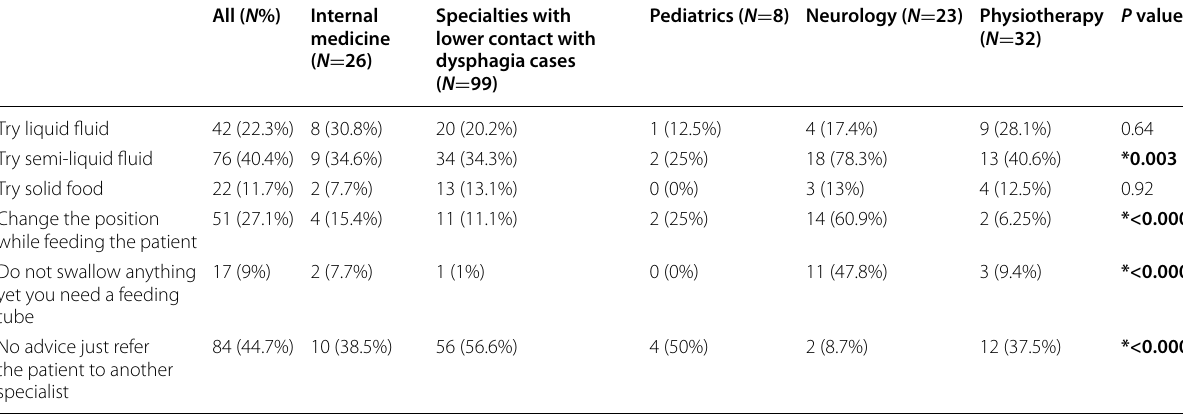
*Significant P value <